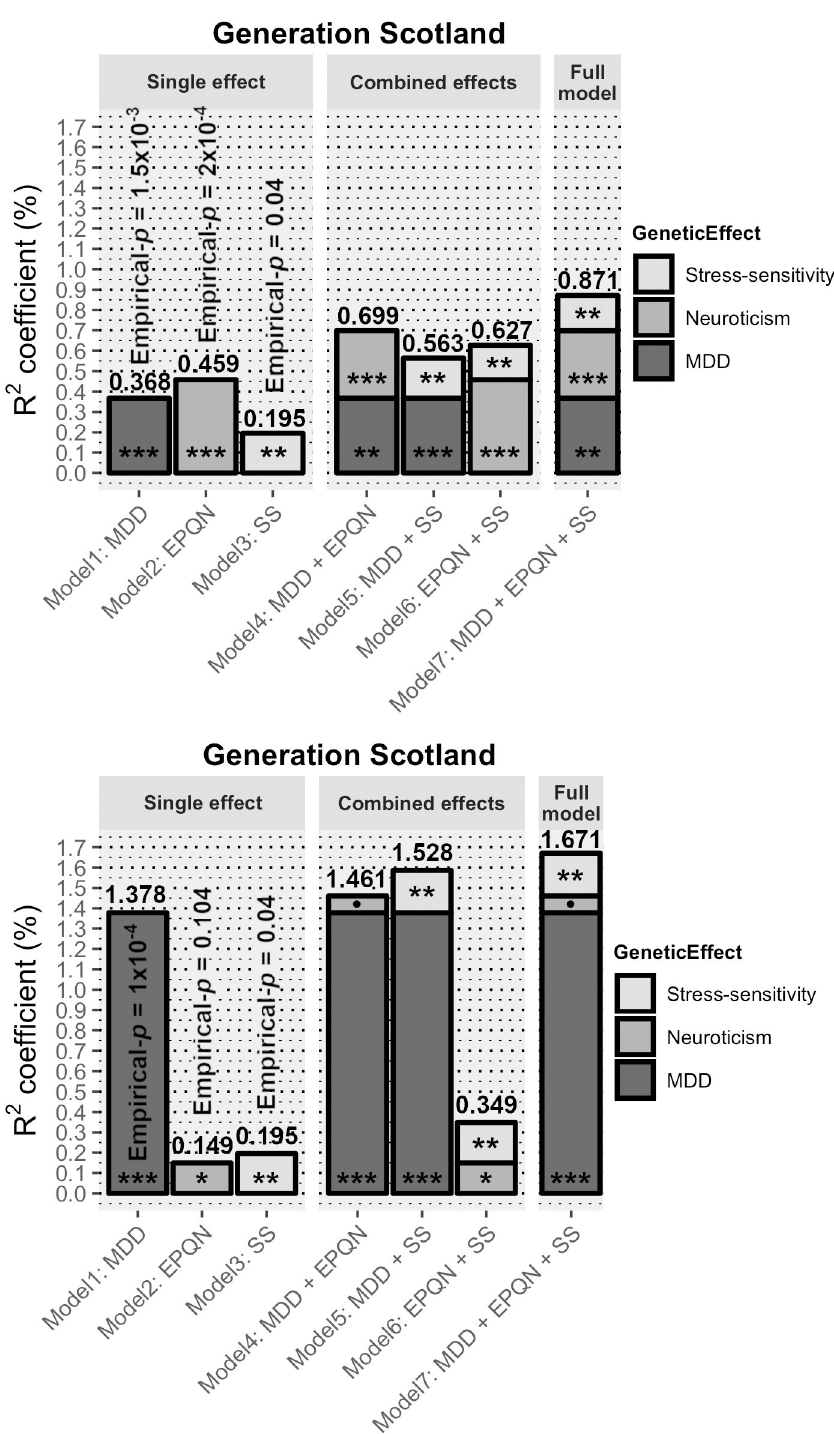
Fig 3. MDD is best predicted using multiple PRS. MDD risk explained (R 2 coefficient (%); top bar values) on the liability scale by each PRS in GS:SFHS; weighted by GWAS main additive and GWIS stress-sensitivity effects independently and combined. (A) Using summary statistics from UKB as discovery sample. There is an increment on MDD risk prediction from adding PRS SS to PRS D model of 53.1% and 24.6% when combining PRS SS with both MDD and neuroticism PRS. (B) Replication of fitting PRS D and PRS N using summary statistics from worldwide consortiums (i.e. PGC &GPC). Significance codes: p values ��� < 0.001 < �� < 0.01 < � < 0.05 < • < 0.1; derived from likelihood ratio tests. SS stands for